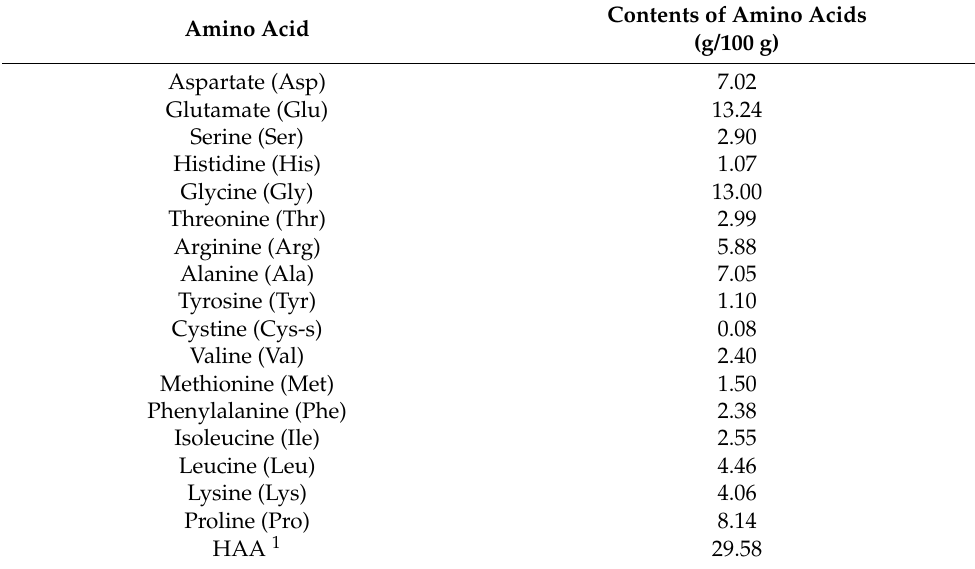
Table 2. Amino Acid Composition of THPH. Amino